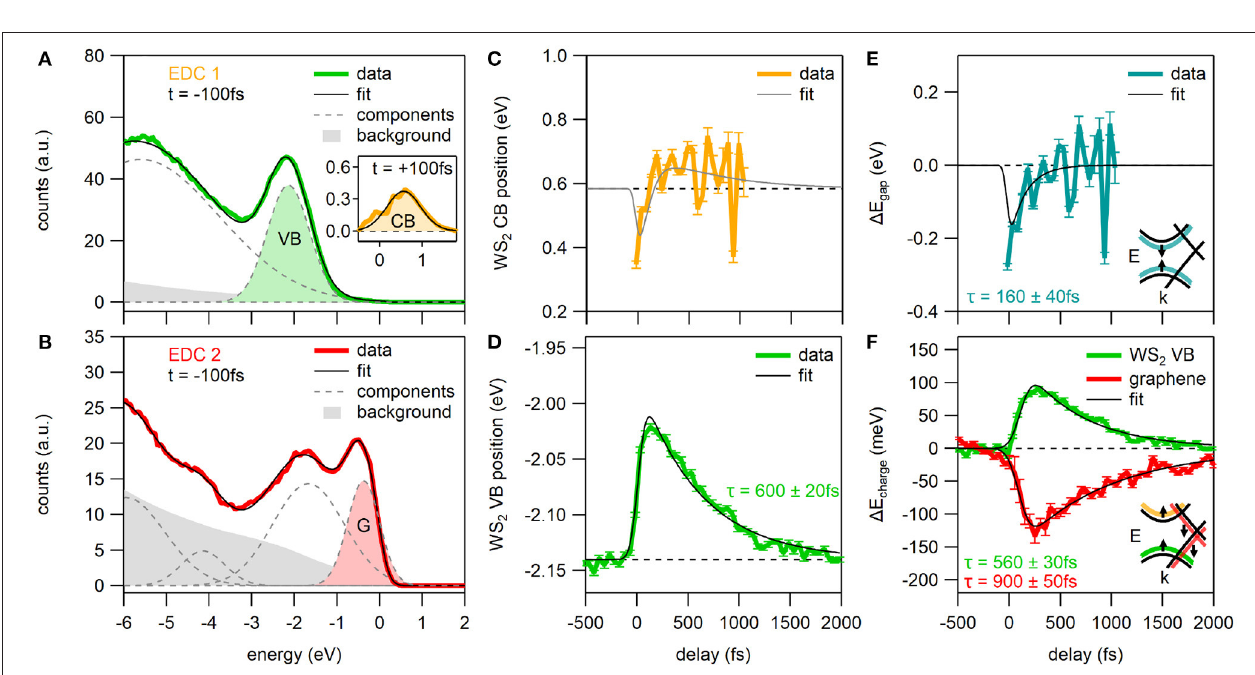
FIGURE 5 | Transient band shifts. (A) EDC1 at negative pump-probe delay together with Gaussian fit. The inset shows the difference EDC1 at the peak of the pump-probe signal used to fit the binding energy of the WS 2 CB with a single Gaussian. (B) EDC2 at negative pump-probe delay together with Gaussian fit. Fit components and Shirley background are displayed as dashed gray lines and gray-shaded areas, respectively, in (A,B) . The peaks that were used to determine the transients peak positions in (C,D,F) are shaded in the respective colors in (A,B) . (C) Transient position of WS 2 CB. (D) Transient position of WS 2 VB. (E) Transient changes of WS 2 band gap calculated by subtracting (D) from (C) . (F) Charging shifts of WS 2 VB and graphene Dirac cone as a function of pump-probe delay. Black lines are exponential fits to the data.